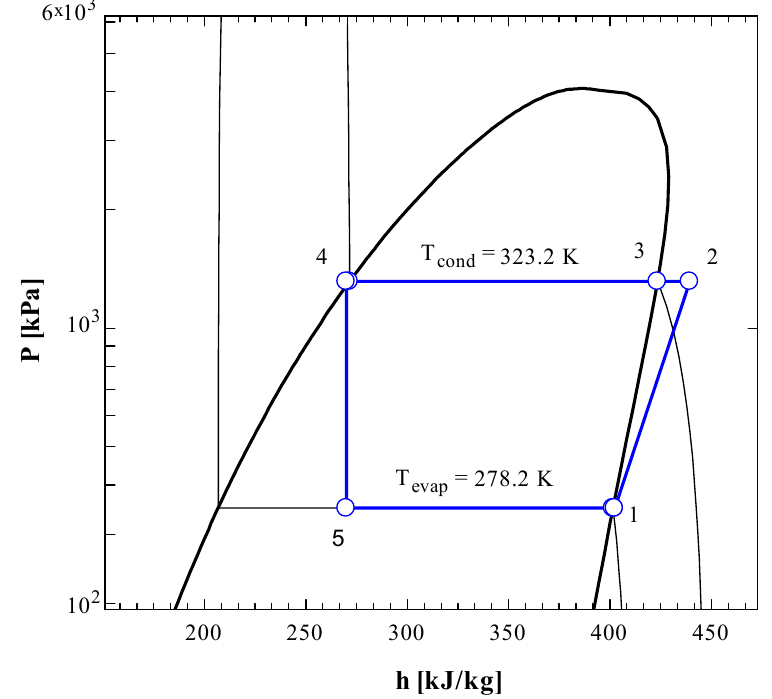
Figure 3 . P-h diagram of vapor compression refrigeration cycle running with R134a .